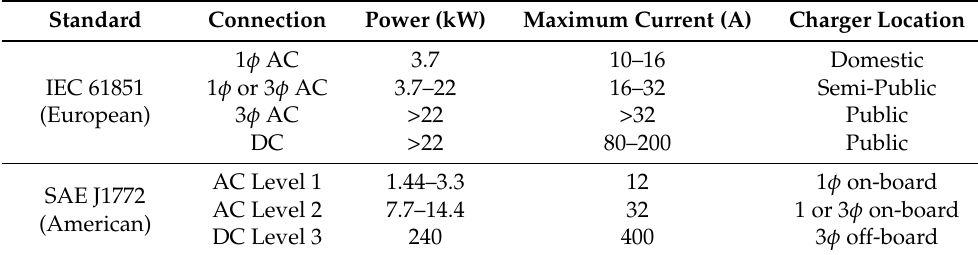
Table 2. Charging levels standards: IEC 61851 (European) and SAE J1772